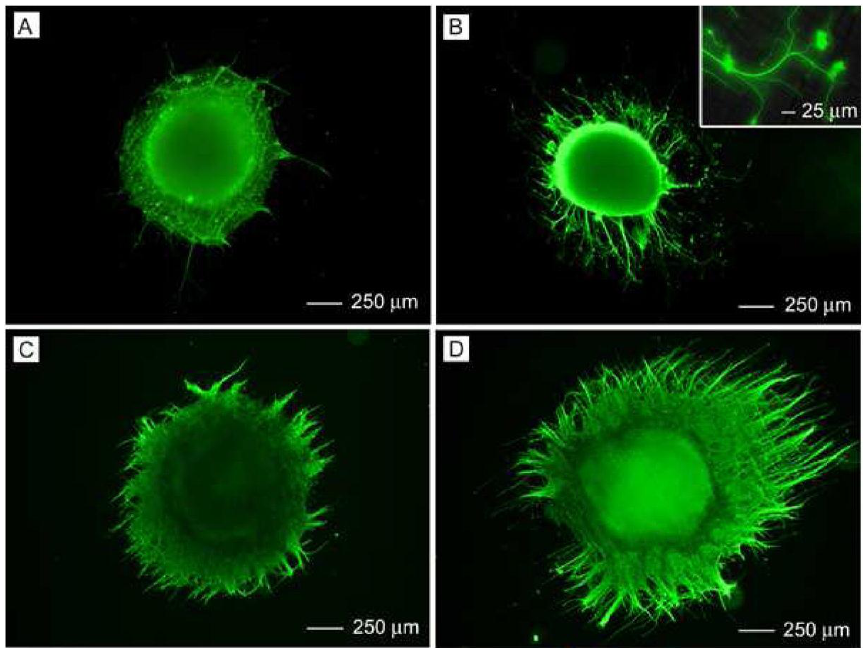
Figure 4. Fluorescence micrographs showing the typical morphologies of DRG cultured on double layered meshes composed of uniaxially aligned fibers with ( A , B ) low and ( C , D ) mediate densities. (B, D) The underlying substrate was polystyrene and coated with PEG and the fibers were then coated with laminin